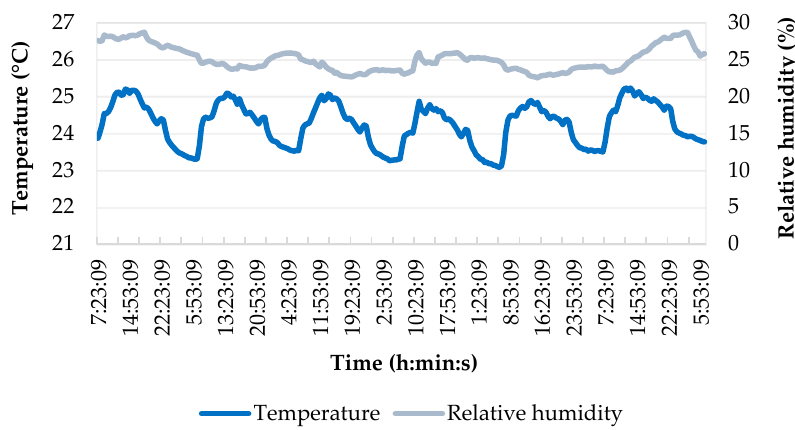
Figure 7. Indoor air temperature and relative humidity fluctuations for MHS.